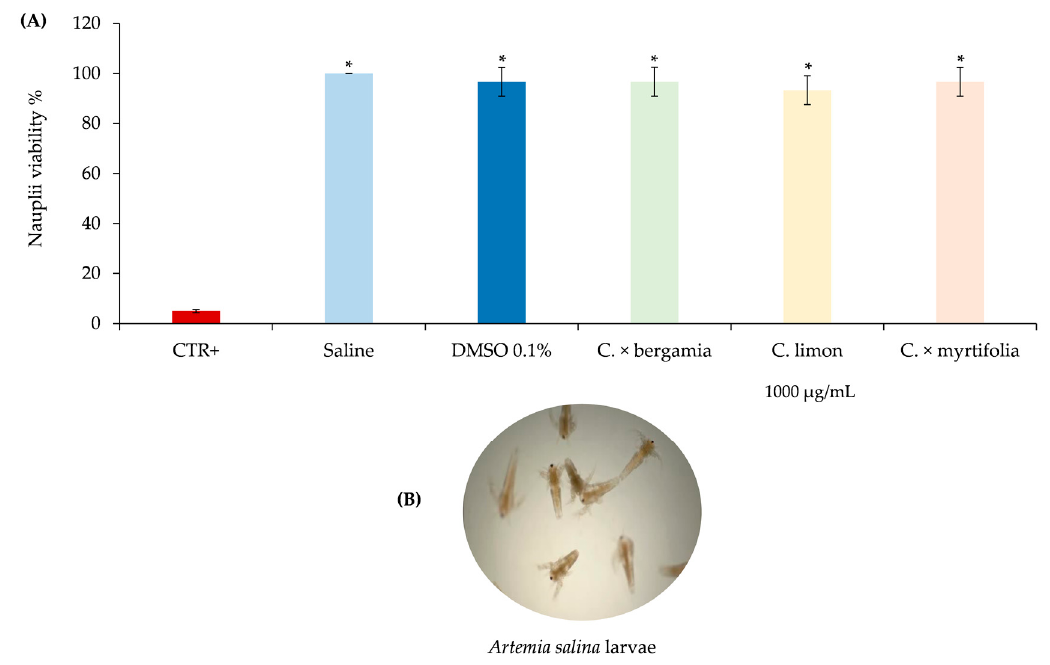
Figure 7. Brine shrimp lethality assay. Positive control (K 2 Cr 2 O 7 50 µ g / mL), negative controls (saline and DMSO 0.1%) as well as the highest concentration (1000 µ g / mL) of the Citrus EOs investigated were provided in panel ( A ). A representative photo of Artemia salina larvae (magnification 10 × ) in the plate well, acquired by a stereomicroscope equipped with a digital camera is reported in panel ( B ). Results are the mean of three independent experiments ± standard deviation.* p < 0.001 vs. CTR +